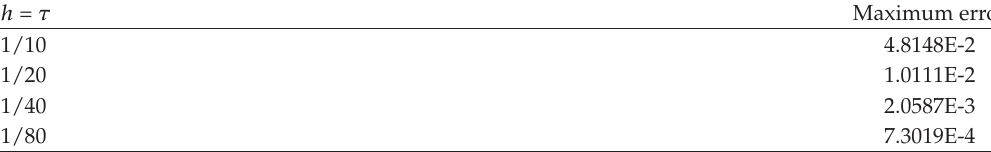
Table 1: Maximum error behavior versus grid size reduction for Example 5.1 at T (cid:7) 1 . 0.